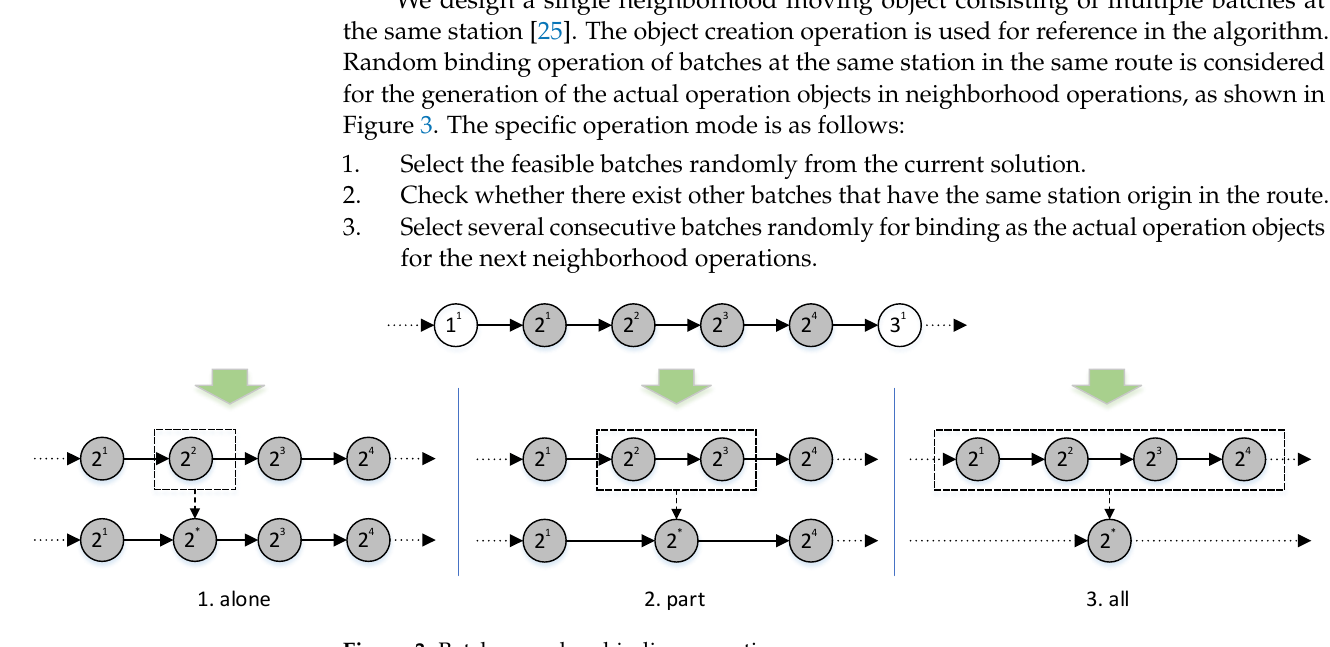
Figure 3. Batches random binding